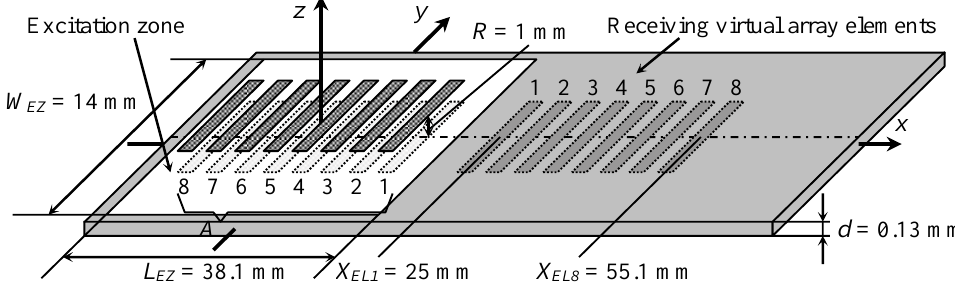
Figure 3. Simulation of reception of slow A 0 Lamb wave mode by air-coupled multi-element array.